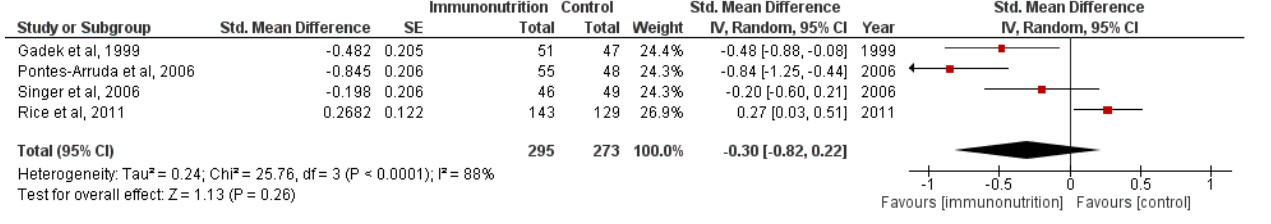
Figure 5. Forest plot of the association between enteral immunomodulatory diet and 28-day ICU-free days among patients with ALI/ARDS.